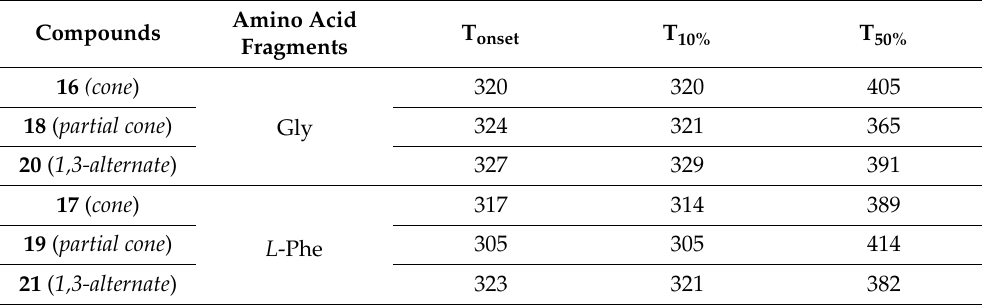
Table 3. TG data for the macrocyclic ILs 16 – 21 ( ◦ C). Amino Acid T onset T Compounds Fragments